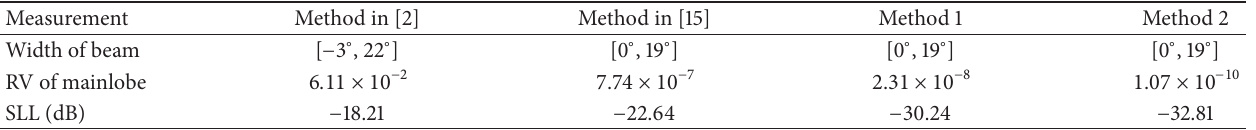
Table 3: Evaluation of four methods.